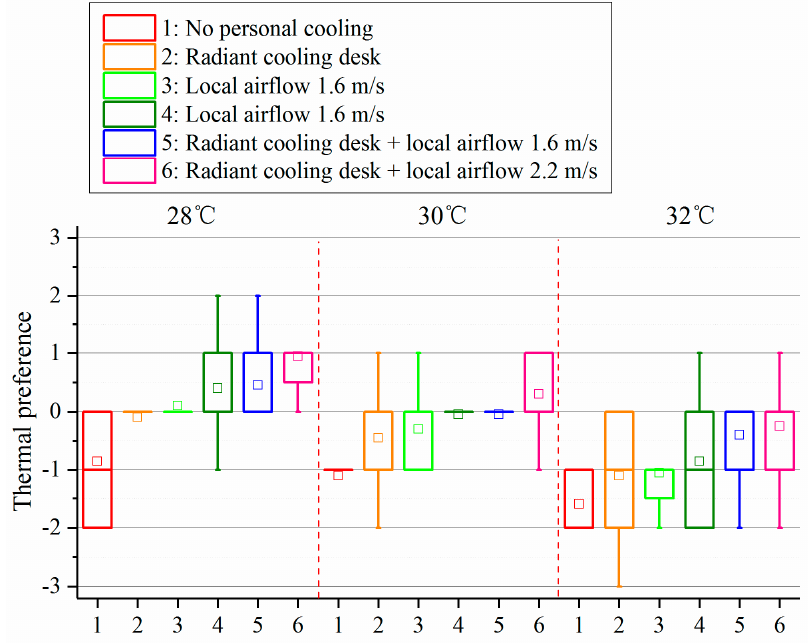
Figure 7. Thermal preference votes in the last votes.